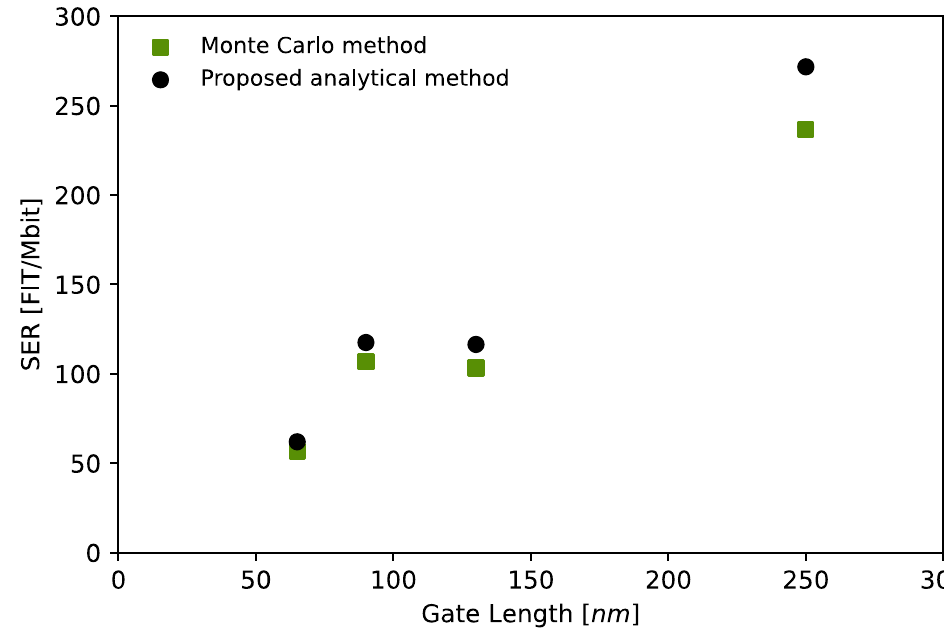
Figure 5. Comparison between the SER (at ground level) obtained by Monte Carlo simulations and the analytical approach developed in this document.